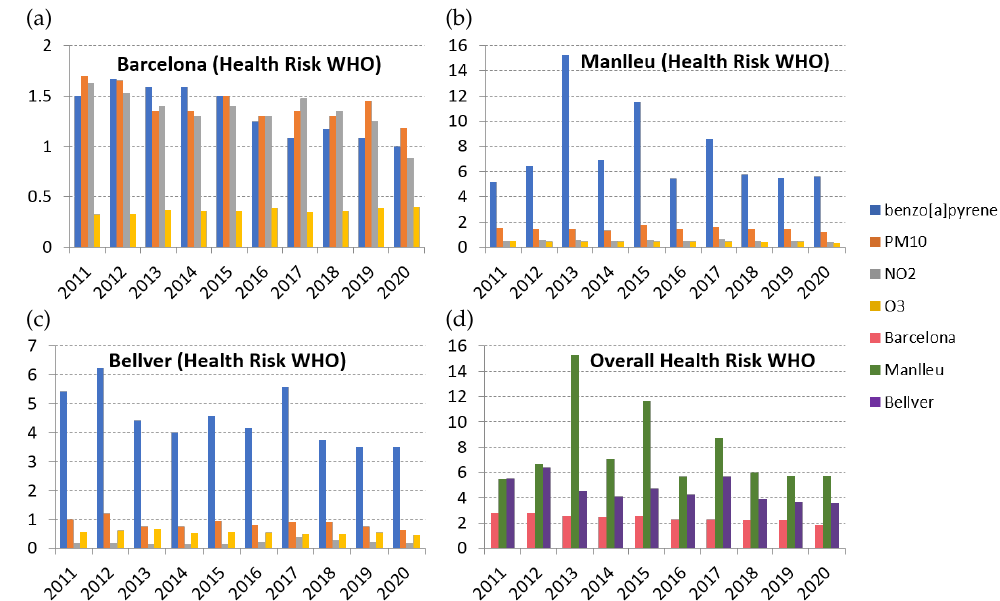
Figure 9. Health risk analysis of air quality in ( a ) Barcelona, ( b ) Manlleu, and ( c ) Bellver de Cerdanya based on the ratio of annual average PM 10 , NO 2 , O 3 , and BAP concentrations versus the WHO air quality standards. Ratio > 1 is an unacceptable health risk. ( d ) Overall health risk is the square root of the sum of squares of the four air quality ratios in the three air quality network